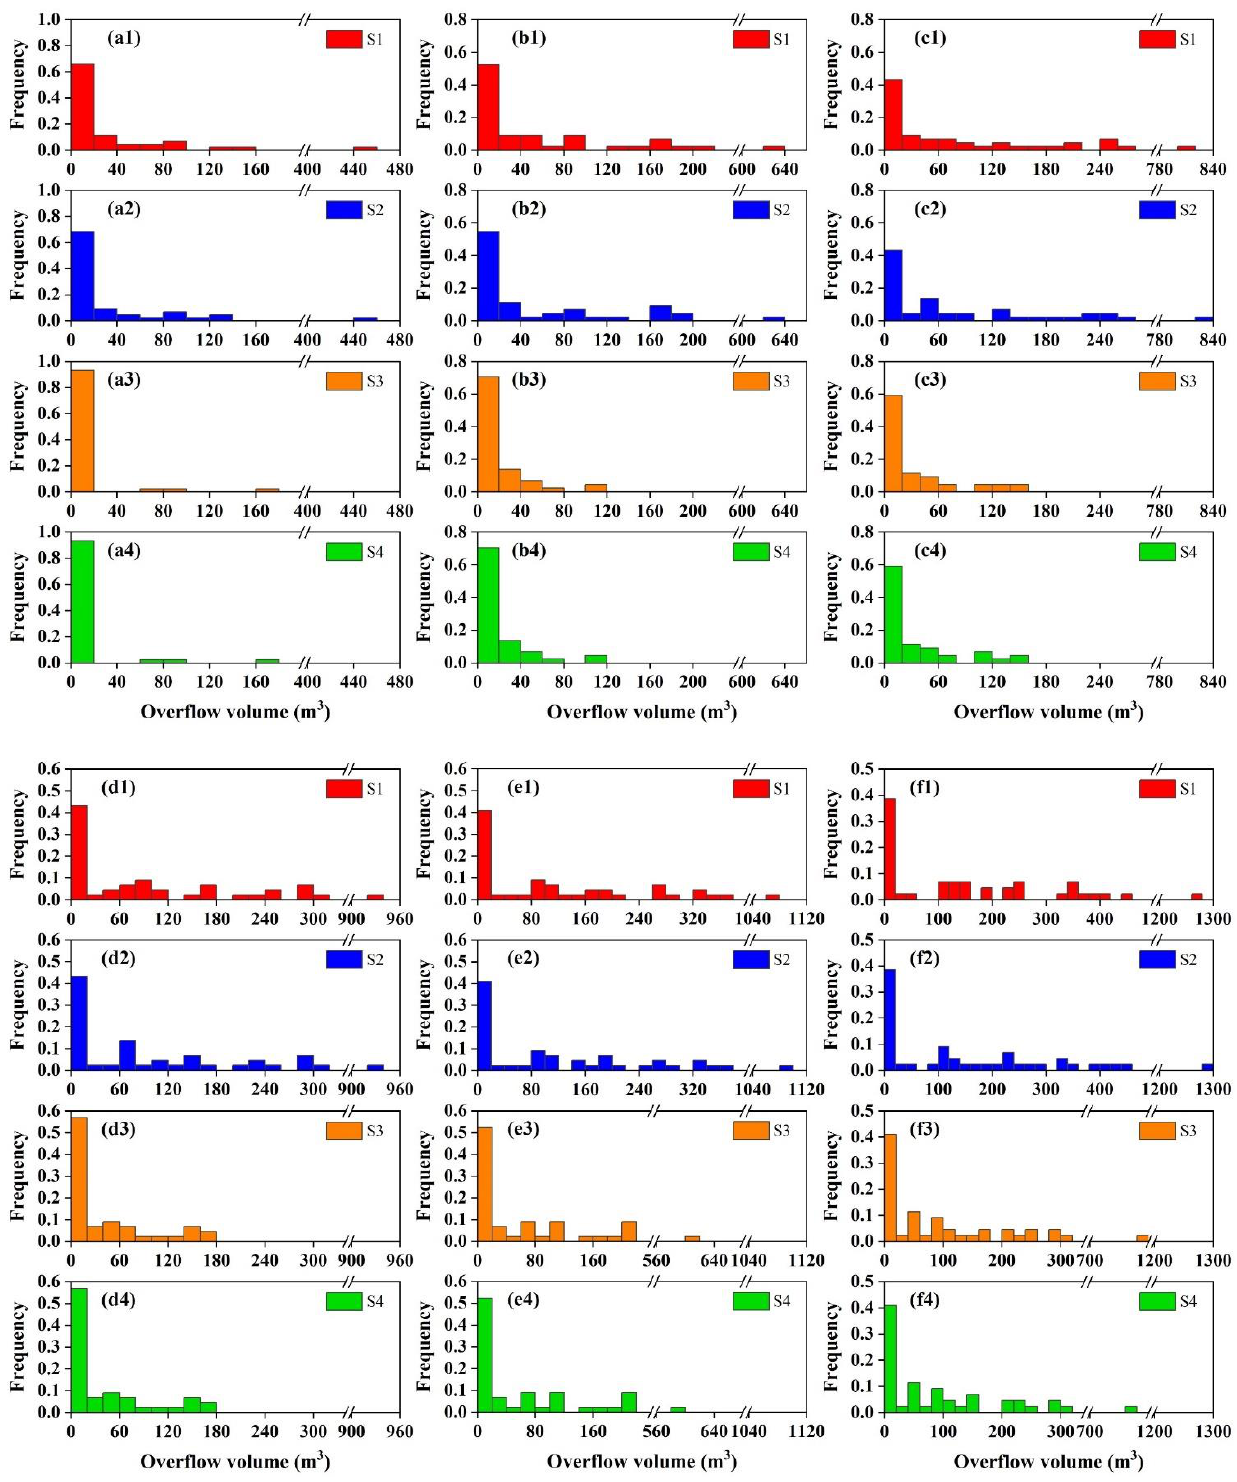
Figure 4. Frequency distribution of overflow volume of junction nodes for the various scenarios (S1, S2, S3, and S4) and rainfall events with return period of ( a1 – a4 ) 5, ( b1 – b4 ) 10, ( c1 – c4 ) 20, ( d1 – d4 ) 30, ( e1 – e4 ) 50, and ( f1 – f4 ) 100 years.